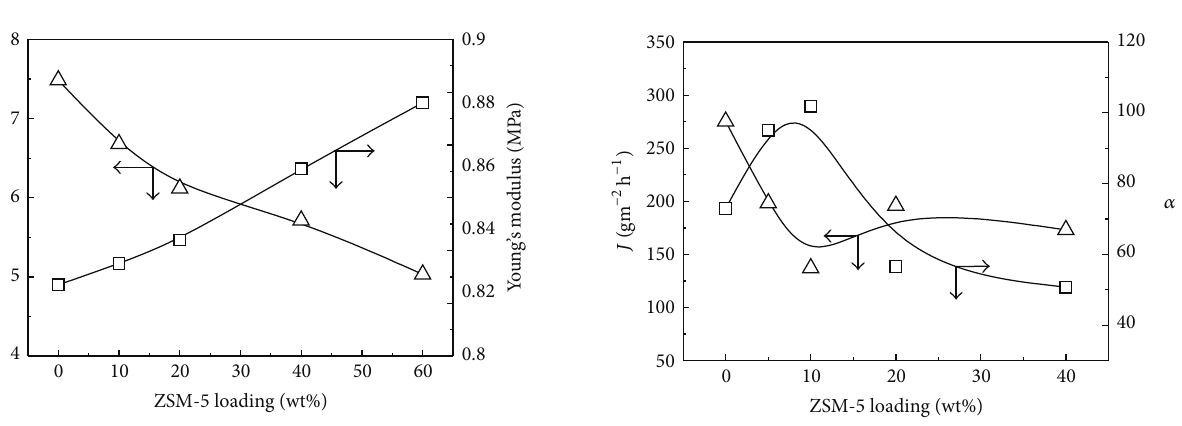
Figure 7: Effect of ZSM-5 loading on PV performance of PEBA/ZSM-5 membranes: separation factor and permeation flux (EA concentration in feed, 5wt%, feed temperature, 30 ∘